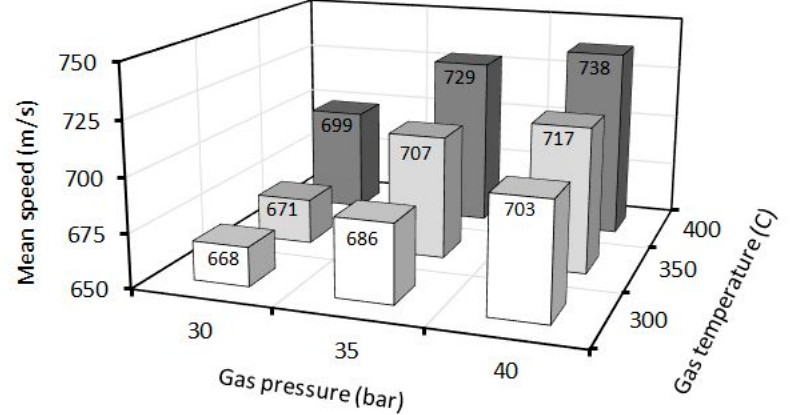
Figure 4. Particle mean velocities sprayed with di ff erent gas pressures and gas temperatures. Meyer et al. [25] have measured particle velocities for Al with the PIV technique and the velocity dependence on the particle mass feed rates, resulting in decreased particle velocities with higher feed rates. Aluminum particles sprayed with the pressure of 15 bar or 30 bar had average particle velocities of ~450 and ~540 m / s, respectively [25], using similar feed rates as we have used. In our study, particle velocities are higher, probably due to the higher gas temperatures and pressures used, di ff erences in particle size and di ff erent particle velocity measuring technique used (PIV vs. PTV). Schmidt et al. [13] have shown critical velocities around 620–660 m / s for Al and its alloys. In this study, all measured velocity values are above this, and therefore, coating formed successfully with all the selected spray